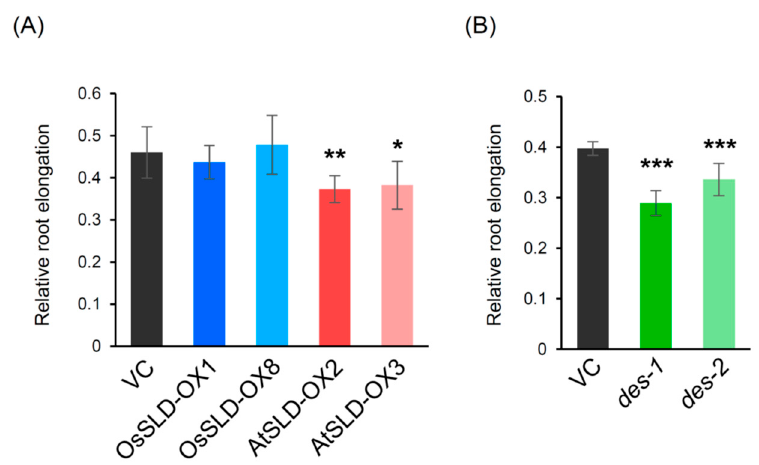
Figure 6. Aluminum tolerance in rice roots. Al 3 + tolerance in SLD-OX ( A ) and des mutant ( B ) was evaluated as relative root elongation (ratio of root length elongated in treated / non-treated conditions). Two typical data obtained independent experiments are shown. Data are means ± SDs ( n = 8). Asterisks indicate statistical significance between vector control (VC) and each transgenic plant (student’s t -test, * P < 0.05, ** P < 0.01, *** P < 0.001).